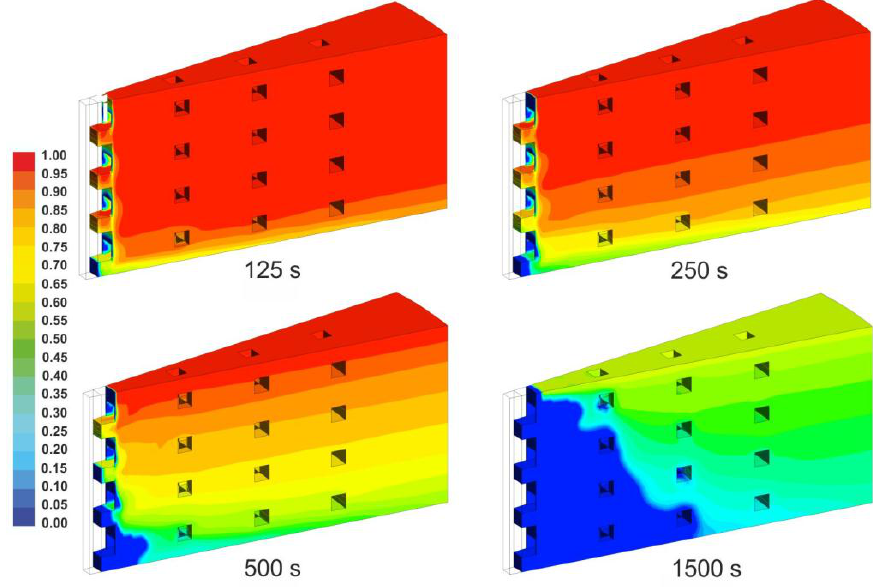
Figure 11. Contours of the liquid fraction of the PCM during the discharging process at different time steps.